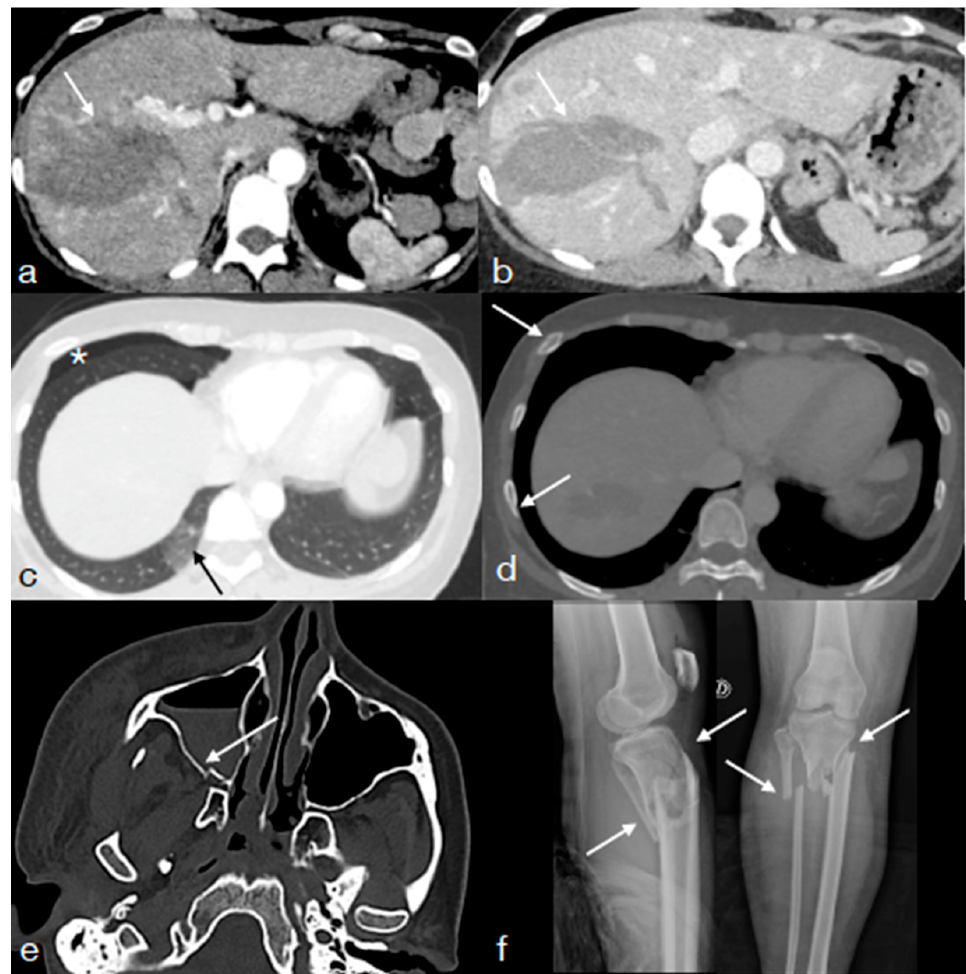
Figure 1. A thirty-four-year-old female underwent high-energy blunt trauma showing in the en- hanced CT performed upon admission for multiple injuries: extensive liver injury, AAST IV (( a ) arterial phase, arrow; ( b ) portal phase, arrow); pulmonary contusions (( c ) straight arrow); low-grade pneumothorax (( c ) asterisk); multiple rib fractures (( d ) arrows); fracture of the maxillary sinus (( e ) arrow); multiple leg fractures (( f ), arrows). This patient needs to be re-imaged with CT in the first imaging follow-up to re-evaluate multiple cranio-facial and body injuries and the possible early development of vascular liver